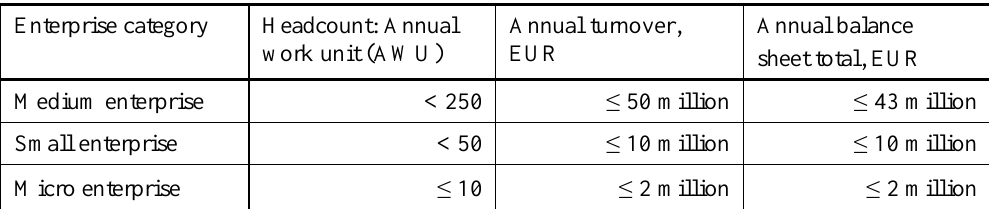
Table 1. Definition of small and medium-sized enterprises according to the European Union standards Enterprise category Headcount: Annual Annual turnover, Annual balance work unit (AWU) EUR sheet total,